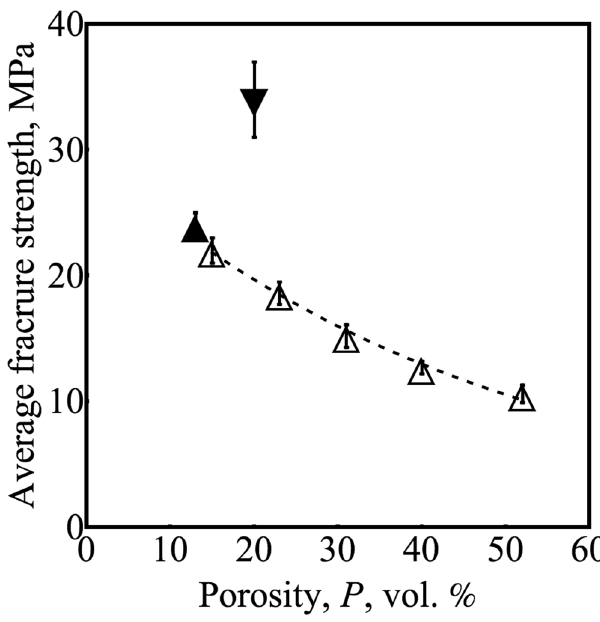
Figure 3. Effect of porosity on the average fracture strength of FDMed SCFR-ABS composites, △ represents the M1, ▲ represents M2 with 100% infill, and ▼ represents M2 at 100% infill in 0° raster orientation. Dotted line represents the fit to σ